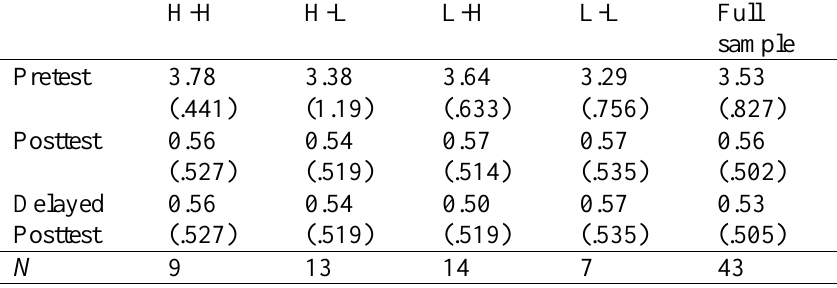
Performance on Content Tasks with Highest Performers Removed